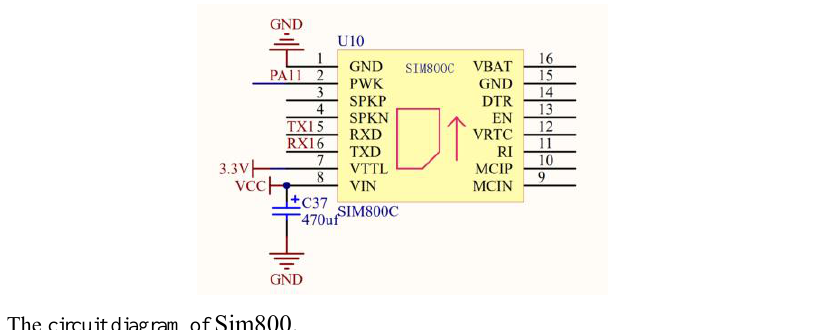
Fig. 5 . The circuit diagram of Sim800.